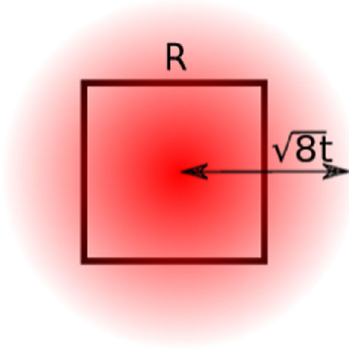
Fig. 1 Schematic representation of a smooth Wilson loop operator. The size of the loop is chosen such that it has the same length as the √ smoothing radius, i.e. R = 8